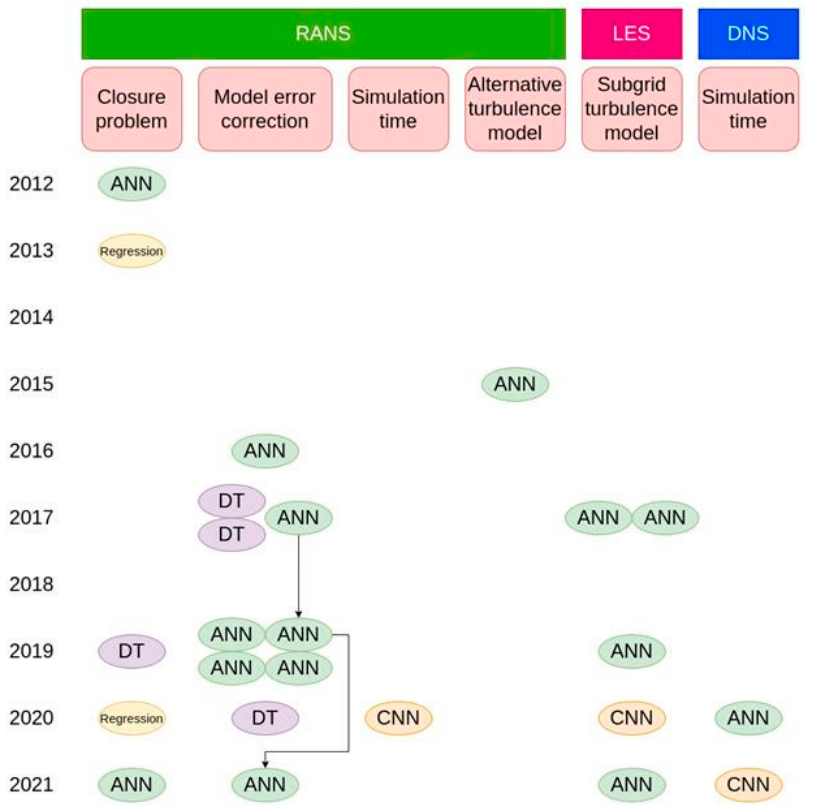
Figure 6. The progress and evolution of the analyzed methods over the last years sorted by the problem defined.